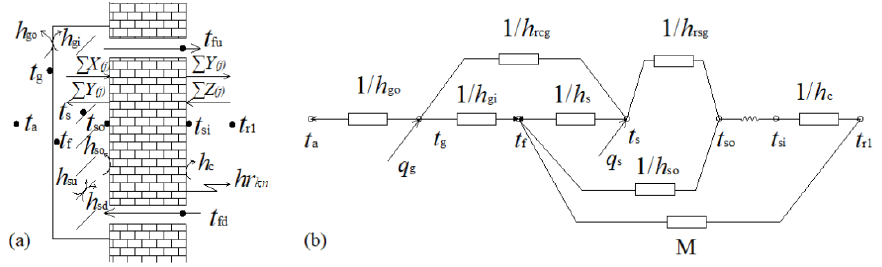
Figure 12. Heat transfer process ( a ) and thermal network model ( b ) of the solar wall.